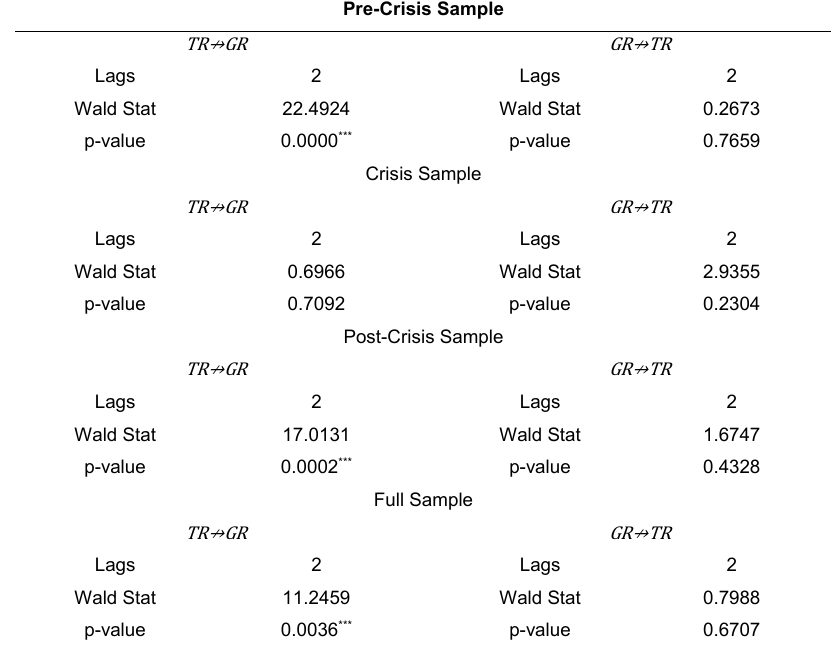
Table 5: Granger Causality Test Results ( 𝐓𝐑 ↛ 𝐆𝐑 (cid:4667) : Pre-Crisis, Crisis, Post Crisis and Full Sample